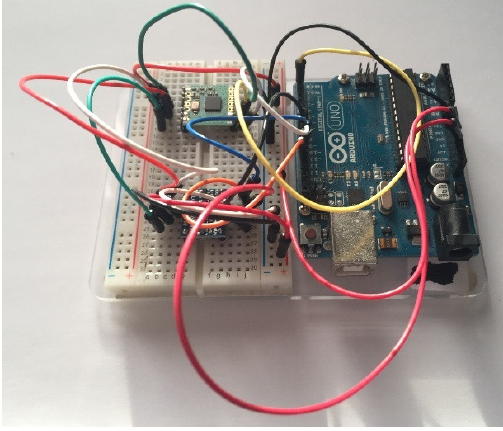
Figure 12. Photo showing the receiver Arduino Uno.